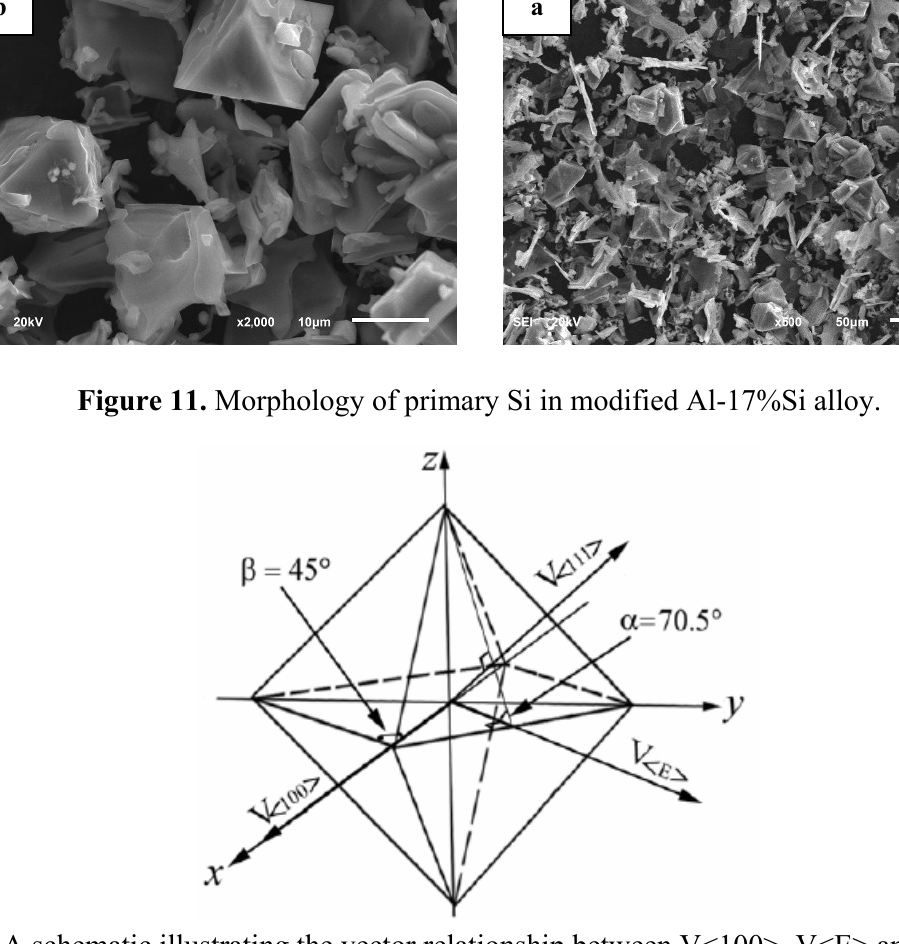
Figure 12. A schematic illustrating the vector relationship between V<100>, V<E> and V<111>